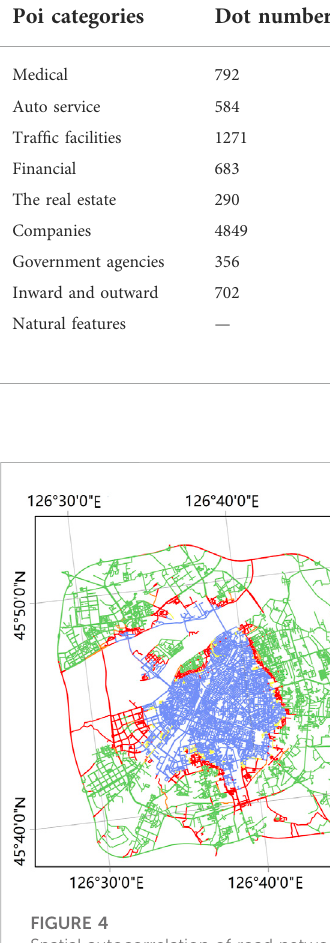
FIGURE 3 The road network spatial topological value of Harbin ’ s MUA. The spatial topological value (total depth) is obtained through the spatial syntax analysis. The higher the spatial topology value, the worse the accessibility of the urban space. The lower the spatial topology value, the better the accessibility.